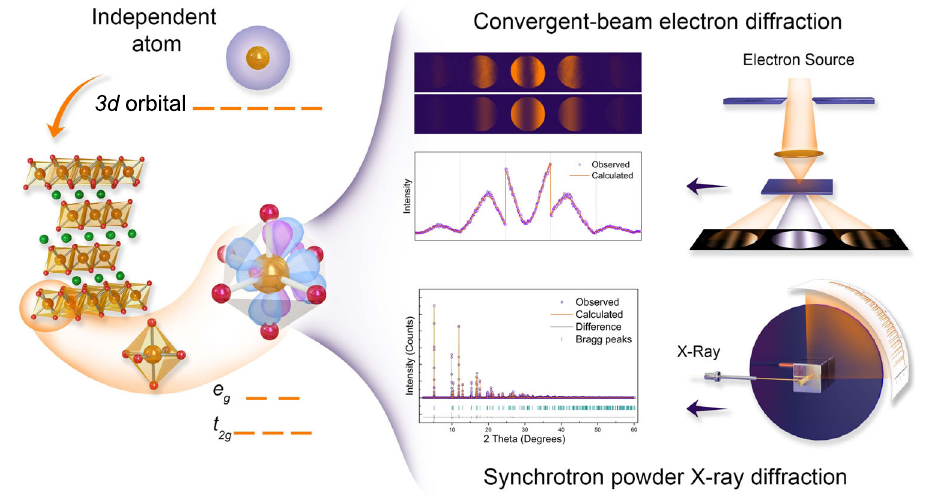
Fig. 1 | Experimentalsetup toobtain thethree-dimensionalelectrondensity of LiCoO 2 . The valence electron distribution of a free independent transition atom (e.g.,Co)isspherical,and its fi ve d -orbitalenergy levelsare degenerate.Inthe case of transition-metal oxides, splitting of the d -orbital energy levels occurs under the crystal fi eldofpolyhedra,andtheredistributionofvalenceelectronsresultingfrom the bonding interactions gives rise to abundant physical properties for functional materials. Using a combination of quantitative convergent-beam electron